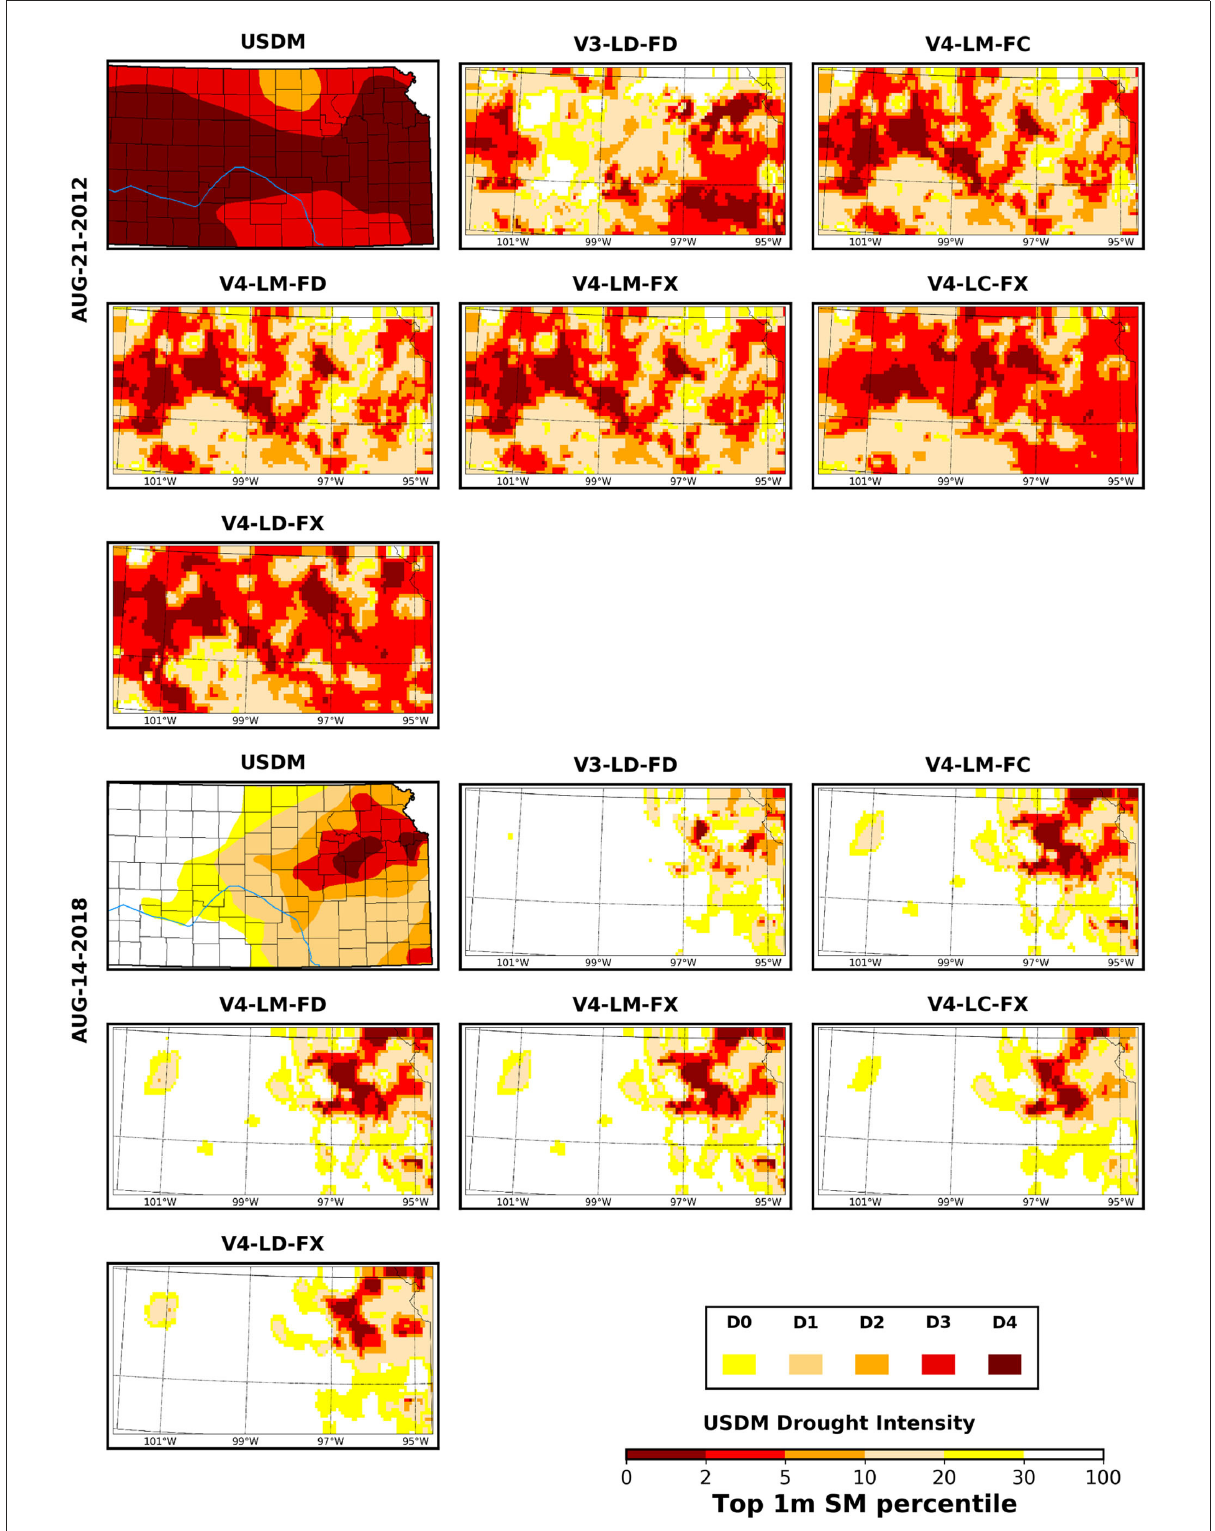
FIGURE11 The US Drought Monitor (USDM) and the modeled soil moisture percentile for the top-1 meter of the soil over the state of Kansas on 21 August 2012, and 14 August 2018. Colors indicate drought categories defined by the USDM, from abnormally dry (yellow) to exceptional drought (dark